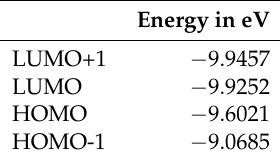
Table 4. Cytochrome C energies near the HOMO–LUMO gap. The energies have been calculated with the semiempirical extended Hückel method implemented in the YaEHMOP package